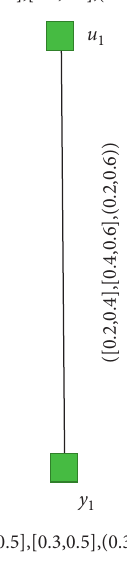
Figure 10: Cubic intuitionistic fuzzy graph.